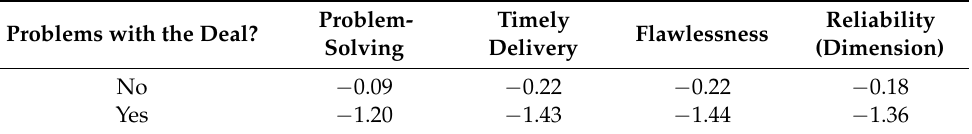
Table 5. Average service quality score for groups with and without problems during the timber deal. Differences between groups are significant on all items ( p < 0.01).